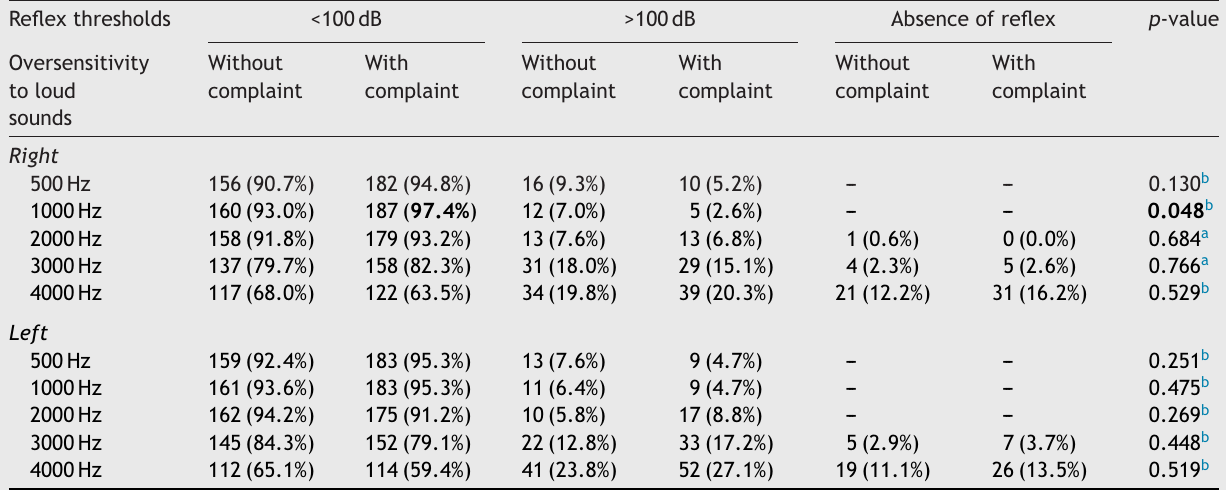
Comparison between oversensitivity to loud sounds and contralateral stapedial reflex thresholds ( n = 364). Reflex thresholds <100